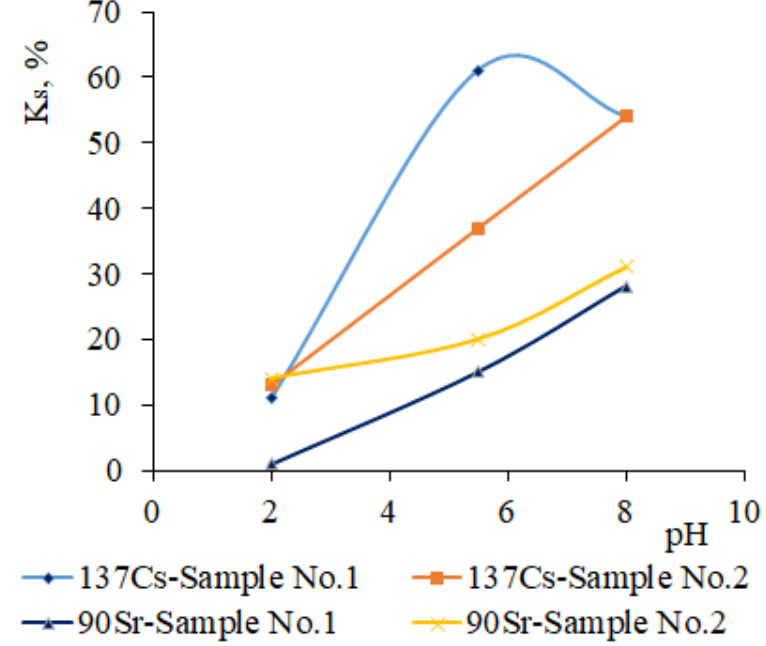
Fig. 3. Kinetics of sorption of radionuclides by model samples of enterosorbents at different pH